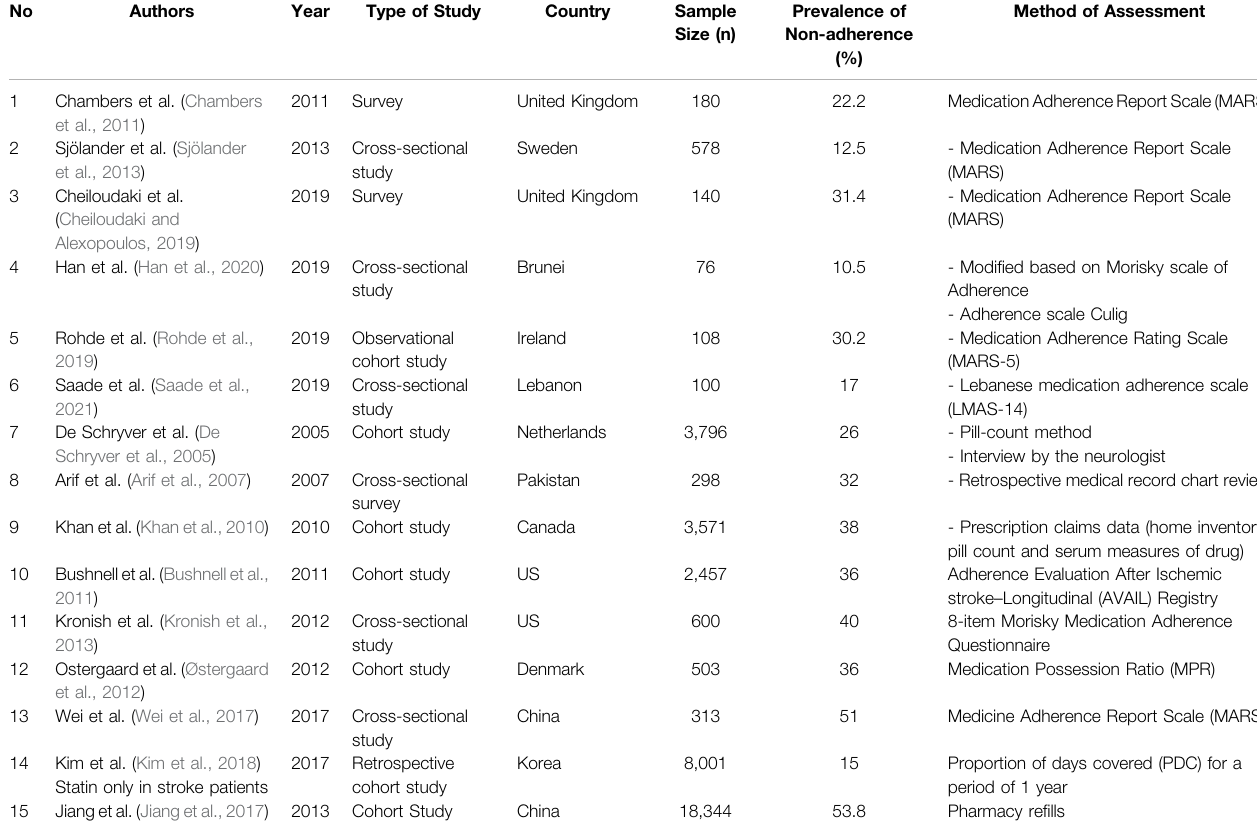
TABLE 3 | Prevalence of adherence and methods of